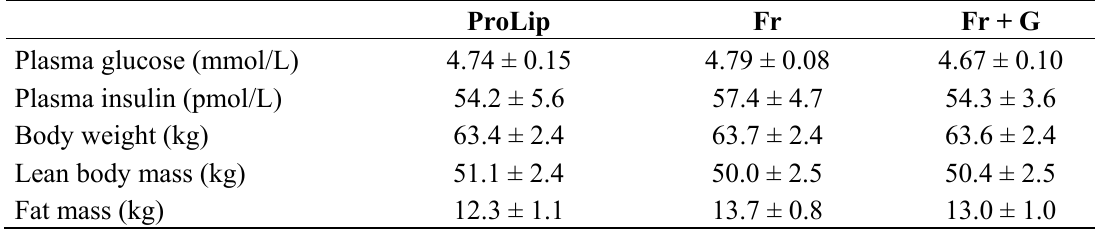
Table 2. Fasting